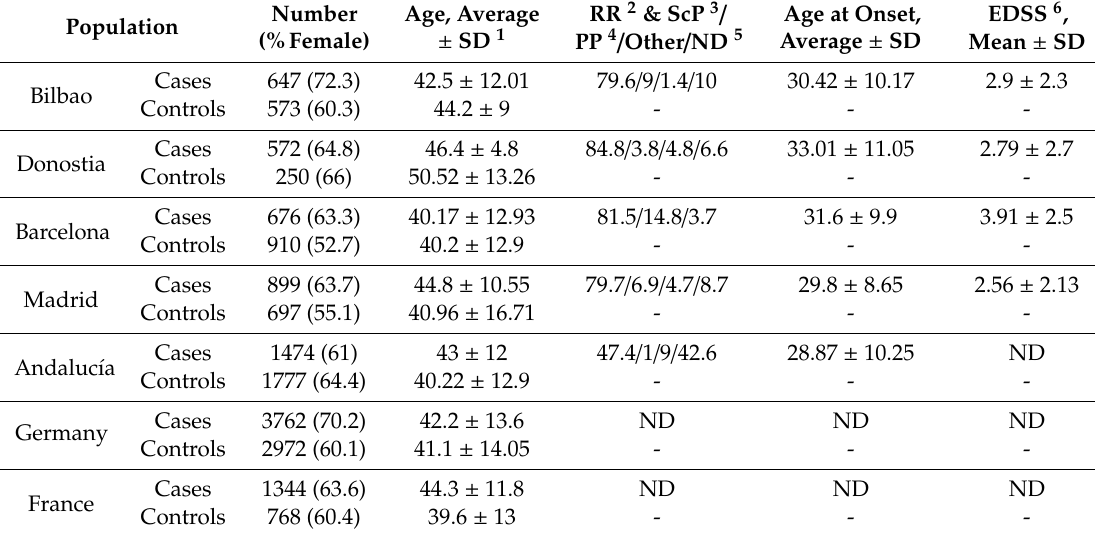
Table 1. Clinical and demographic features of patients and controls included in the genetic study.